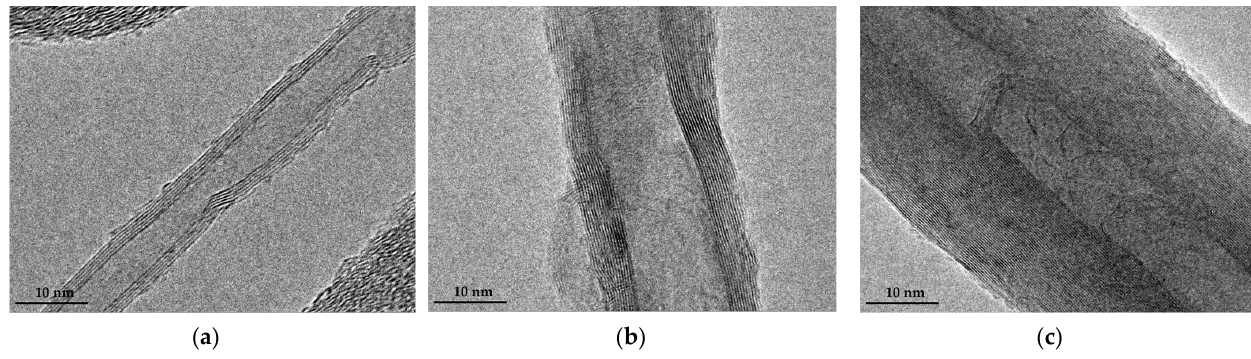
Figure 12. SEM images of CNTs synthesized under a C 2 H 2 flow rate of 100 ( a ); 200 ( b ); 300 sccm ( c ).